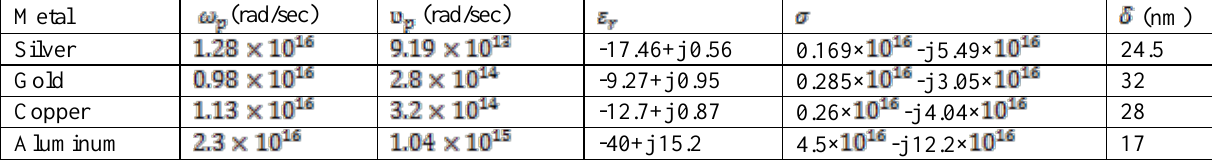
Table I. The optical properties of the different types of metals at 474 THz [17] Metal